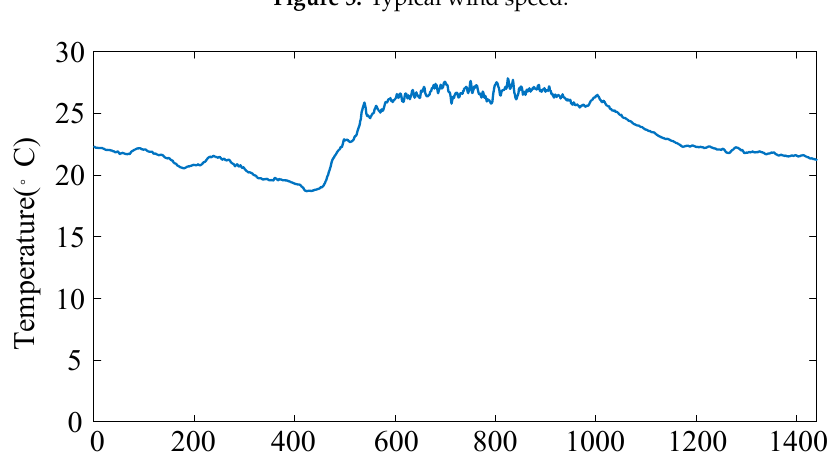
Figure 5. Typical wind speed.